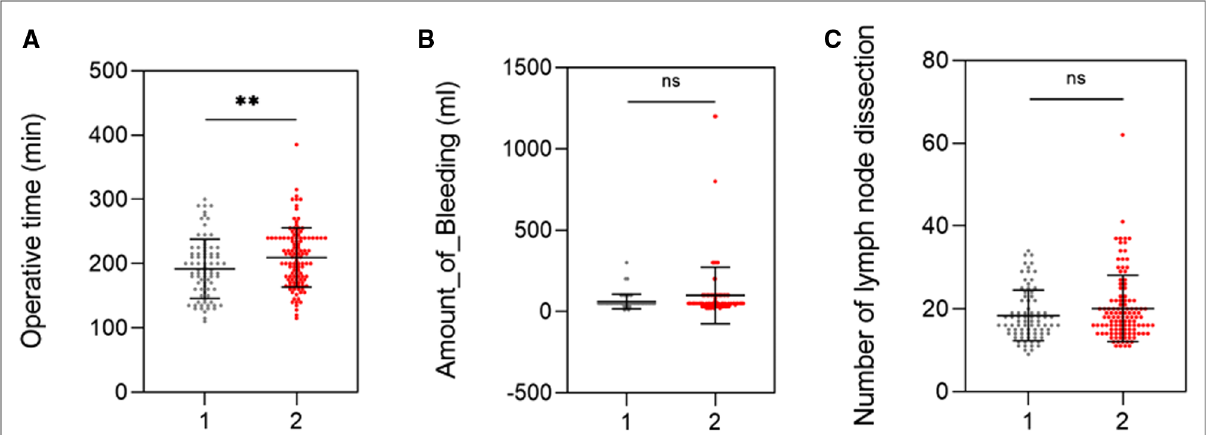
FIGURE 3 Comparison of intraoperative variables between the two groups of patients. ( A ) Operative time. ( B ) Amount of bleeding. ( C ) Number of lymph node dissection.